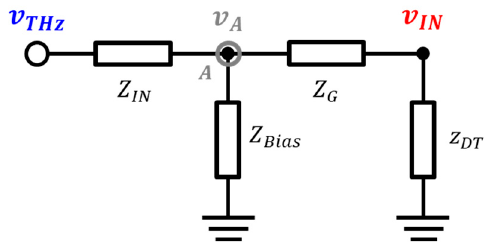
Figure 2. Schematic diagram by using the proposed superposition method at the input interconnection lines of the plasmon detector.